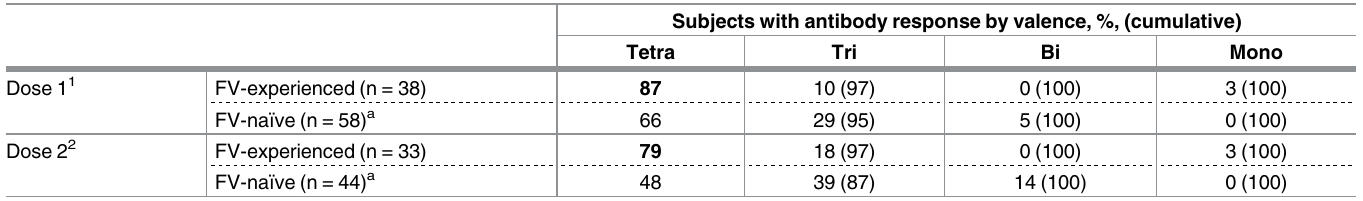
Table 6. Valency of DENV responses after one or two doses of TV003 in subjects who were flavivirus-experienced or -na ï ve a prior to vaccination. Subjects with antibody response by valence, %, (cumulative) Tetra Tri Bi Mono Dose 1 1 FV-experienced (n = 38) 87 10 (97) 0 (100) 3 (100) Dose 2 2 FV-experienced (n = 33) 0 (100) FV-na ï ve (n = 44) a 0 (100) Frequency of tetravalent responses after 1 or 2 doses of TV003 (measured between days 0–180 after dosing) administered to subjects who were flavivirus- exposed versus flavivirus–na ï ve prior to vaccination at Day 0. BOLD indicates statistical significance between FV-experienced versus FV-na ï ve by Chi- square exact test of proportions.